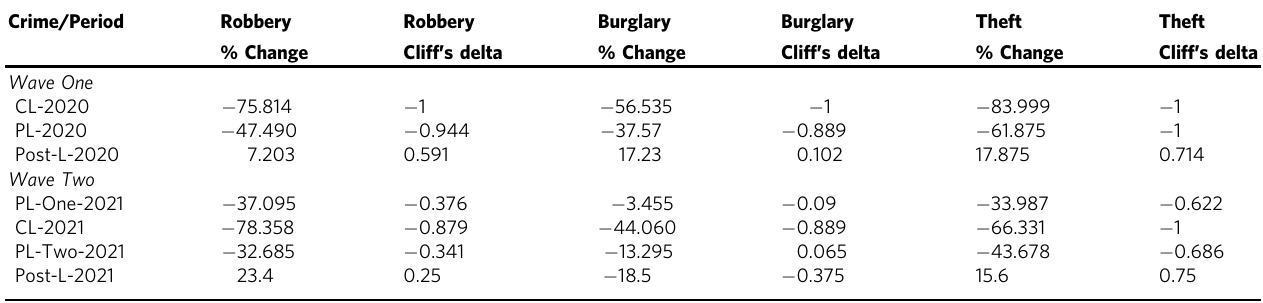
Fig. 4 Impact of the fi rst two waves COVID-19 on property offences. a – c Plot of the actual and predicted daily count of robbery, burglary and theft cases (on Y -axis) in Tamil Nadu during the differing intensities of lockdown in two waves of COVID-19 in 2020 and 2021 (on X -axis). The vertical bars indicate the phases of lockdown (CL complete lockdown, PL partial lockdown, Post-L post-lockdown). The prediction is done using auto-regressive recurrent neural networks. Table 6 The percentage difference between actual and predicted registered property offences along with effect size (Cliff ’ s Delta) during various phases of lockdowns in both waves in 2020 and 2021 in